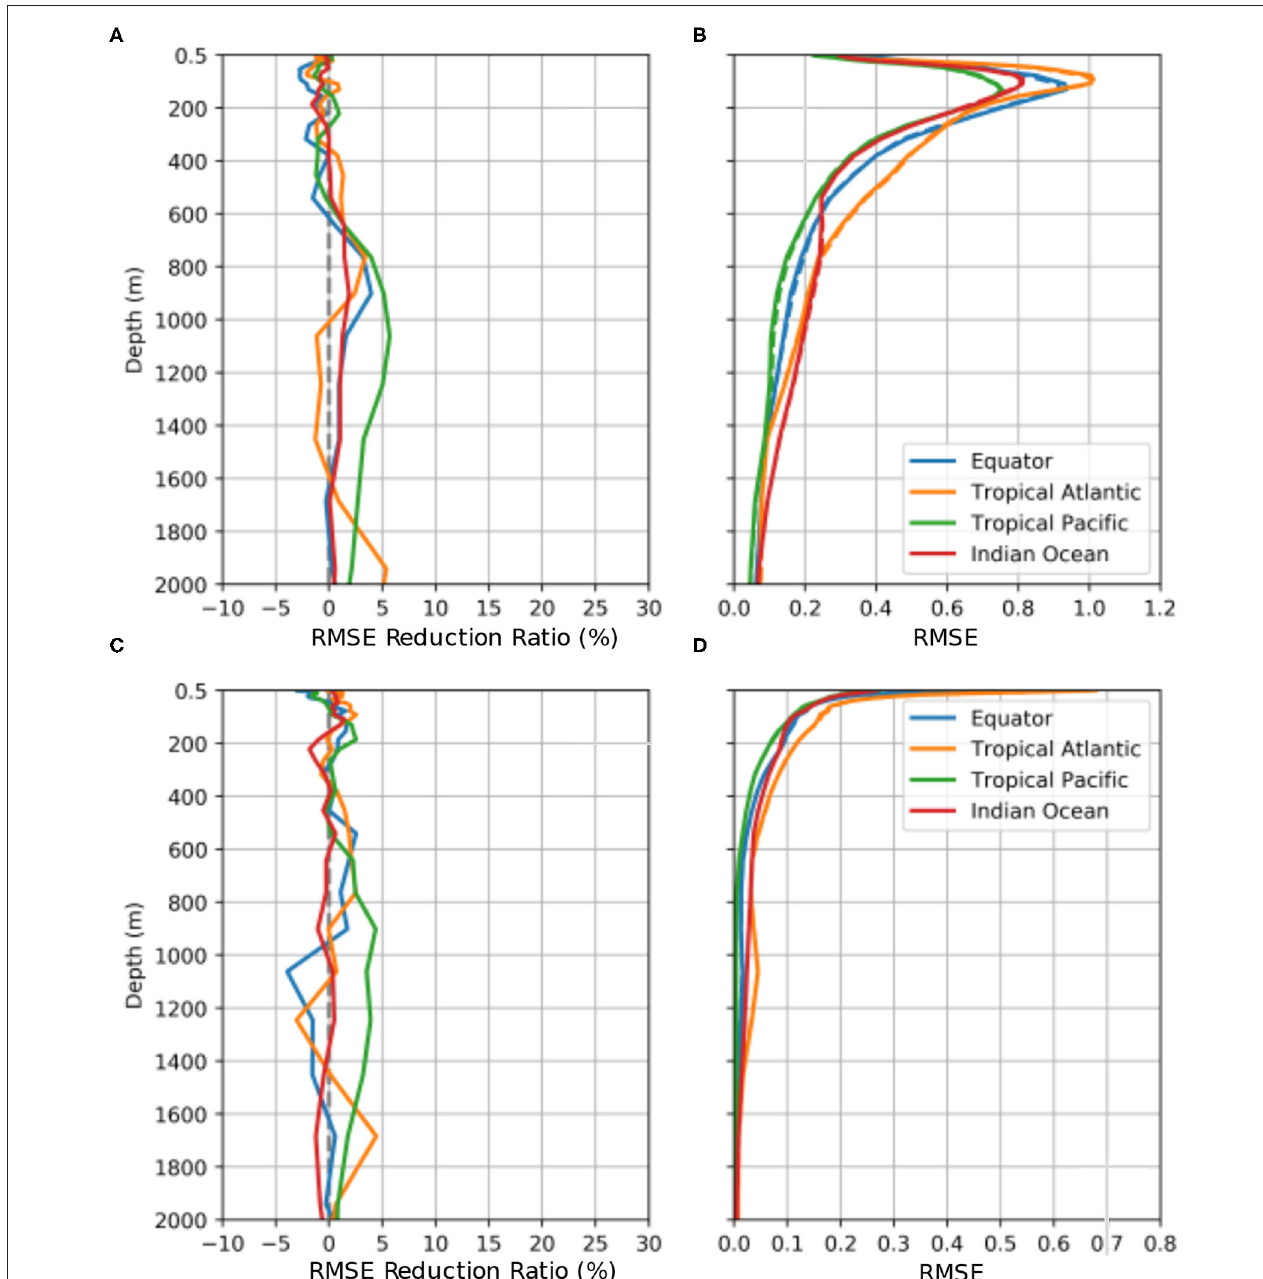
FIGURE 10 | RMSE reduction (as defined by Equation3) and RMSE of NoMoor-NR compared to Backbone-NR in four geographical regions: (A) temperature RMSE reduction, (B) temperature RMSE of NoMoor (solid lines) and BB (dashed lines), (C) salinity RMSE reduction, and (D) salinity RMSE of NoMoor (solid lines) and BB (dashed lines). Blue: Equator, orange: Tropical Atlantic, green: Tropical Pacific, red: Indian